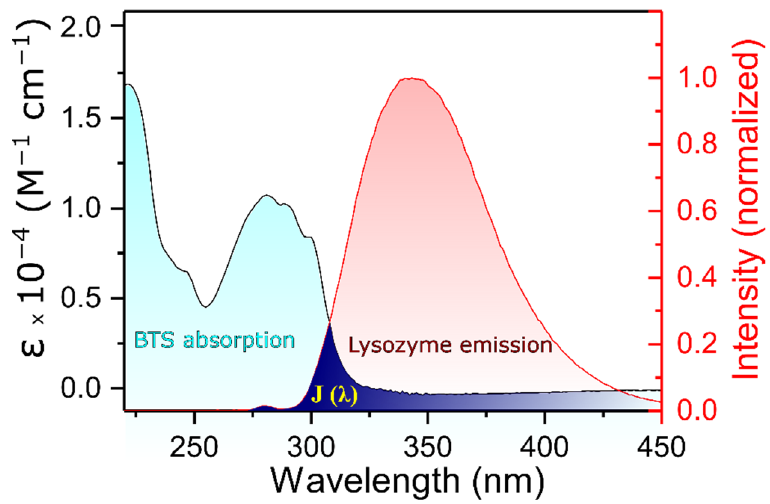
Figure 4. The overlap (dark blue) of the fluorescence emission spectrum of lysozyme (red) and the absorption spectrum of BSA (light blue) ( T = 298 K); C lysozyme = C BTS = 0.02 mM.